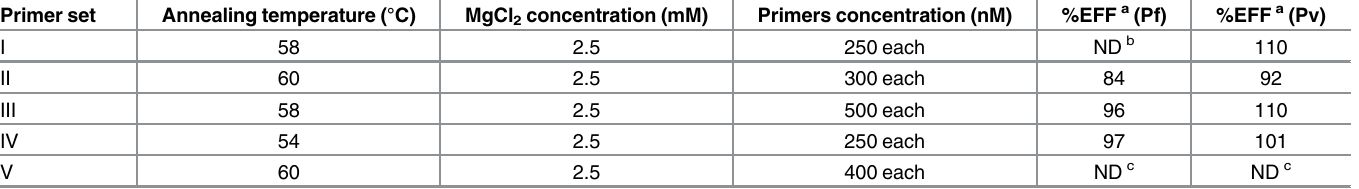
V 60 ND c ND, not determined; Pf , Plasmodium falciparum ; Pv , Plasmodium vivax; EFF , ef fi ciency of the PCR. a %EFF: ef fi ciency (EFF) of the PCR calculated with the formula EFF = 10 (-1/slope) - 1 and expressed as a percentage. An ef fi ciency of 100% corresponds to a slope of -3.32 and means that the number of amplicons doubles after each cycle of ampli fi cation. Ef fi ciency was calculated from serial dilutions of calibrated Pf and Pv sporozoite standards.